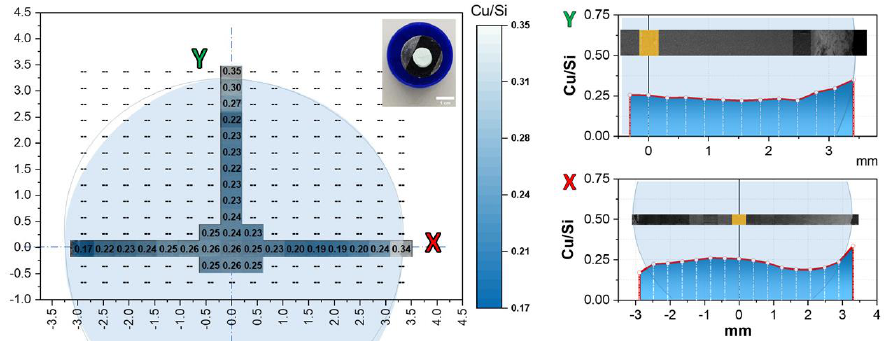
Figure 2. Composite image of SEM micrographs of CuO@SiO 2 -MN and related EDS analysis. The picture shows the SEM-EDS analysis area/micrograph recorded by single frames of 291.10 µm × 388.22 µm across the sample section. Full EDS spectra and calculated atomic% for Cu and Si were recorded for each frame. In the picture, we report the Cu/Si signal ratio to follow the sample morphology and to smooth working distance changes. In the inset, a picture of the sample section mounted onto the SEM pin for SEM-EDX analysis.